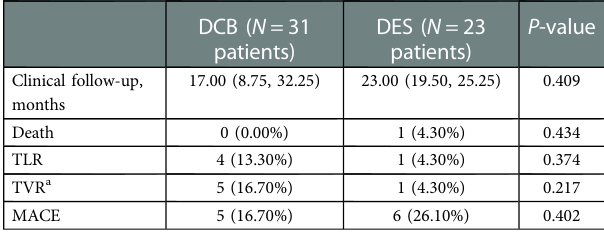
TABLE 4 Clinical results according to treatment